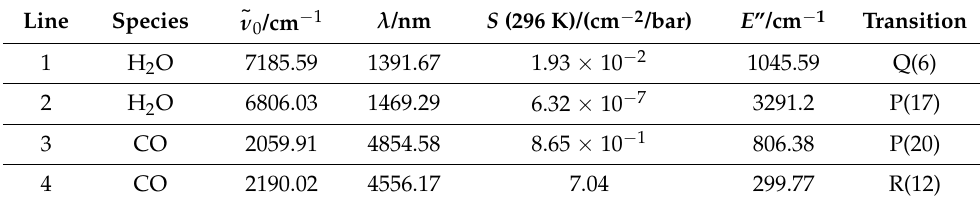
Table 1. Spectroscopic parameters of chosen main